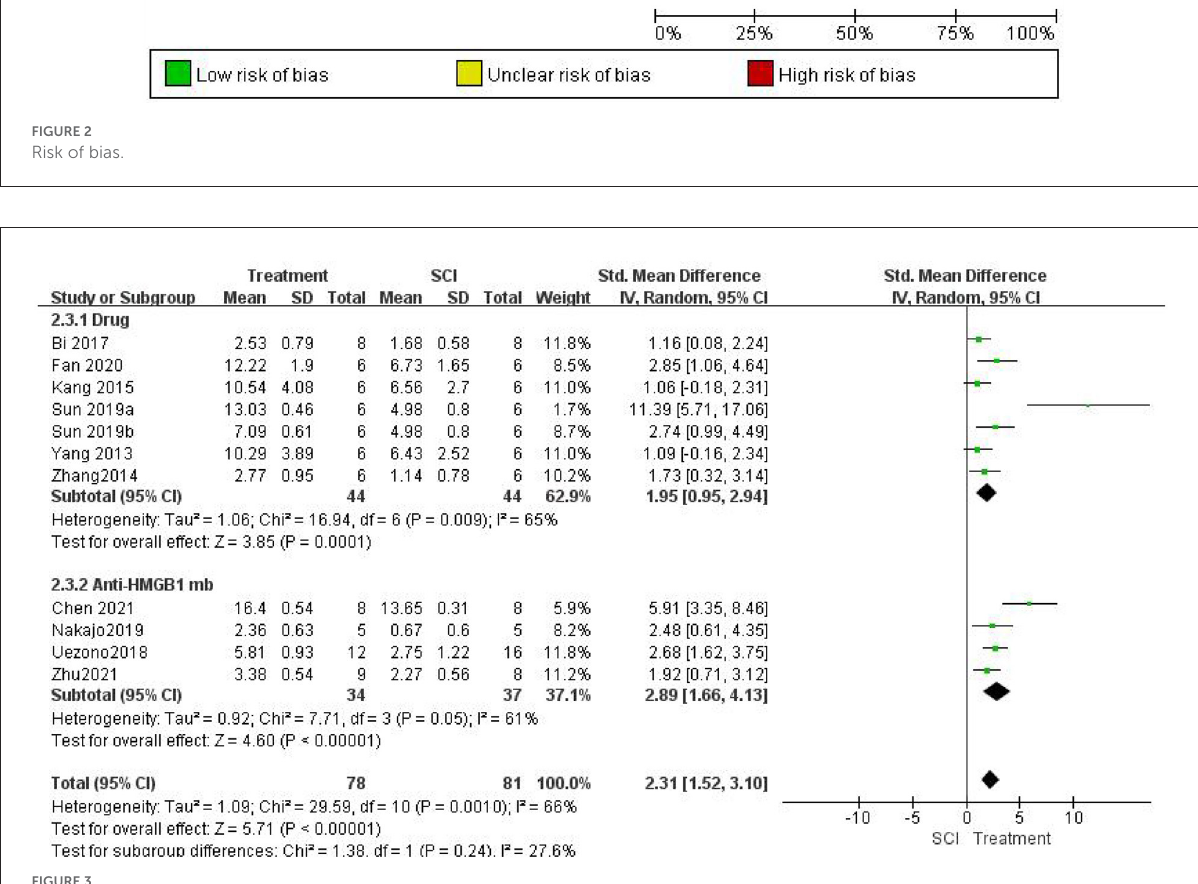
FIGURE3 Forest plot for the effects of HMGB1 intervention on locomotor function scores in SCI (random-effects model). Green dots indicate weighted effect sizes for 11 treatment regimens and error bars indicate 95% confidence intervals for each outcome. Heterogeneity of the study is indicated by the I2 statistic. p < 0.001 indicates statistical